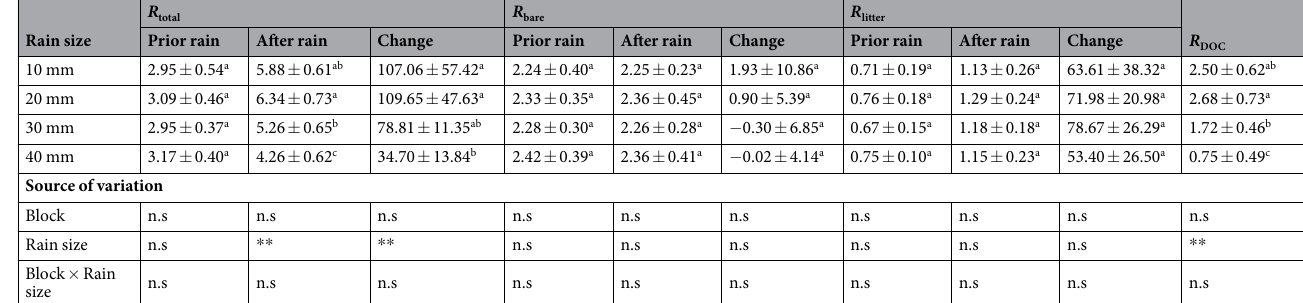
Table 1. Soil CO 2 flux ( µ mol CO 2 m − 2 s − 1 ) prior to and after simulated rains, and rain-induced percentage changes (%) in soil CO 2 flux. Values are means ± SD (n = 5). R total , R bare , R litter , and R DOC , represent total soil CO 2 flux, bare soil CO 2 flux, litter CO 2 flux, and litter DOC-contributed CO 2 flux, respectively. Statistically